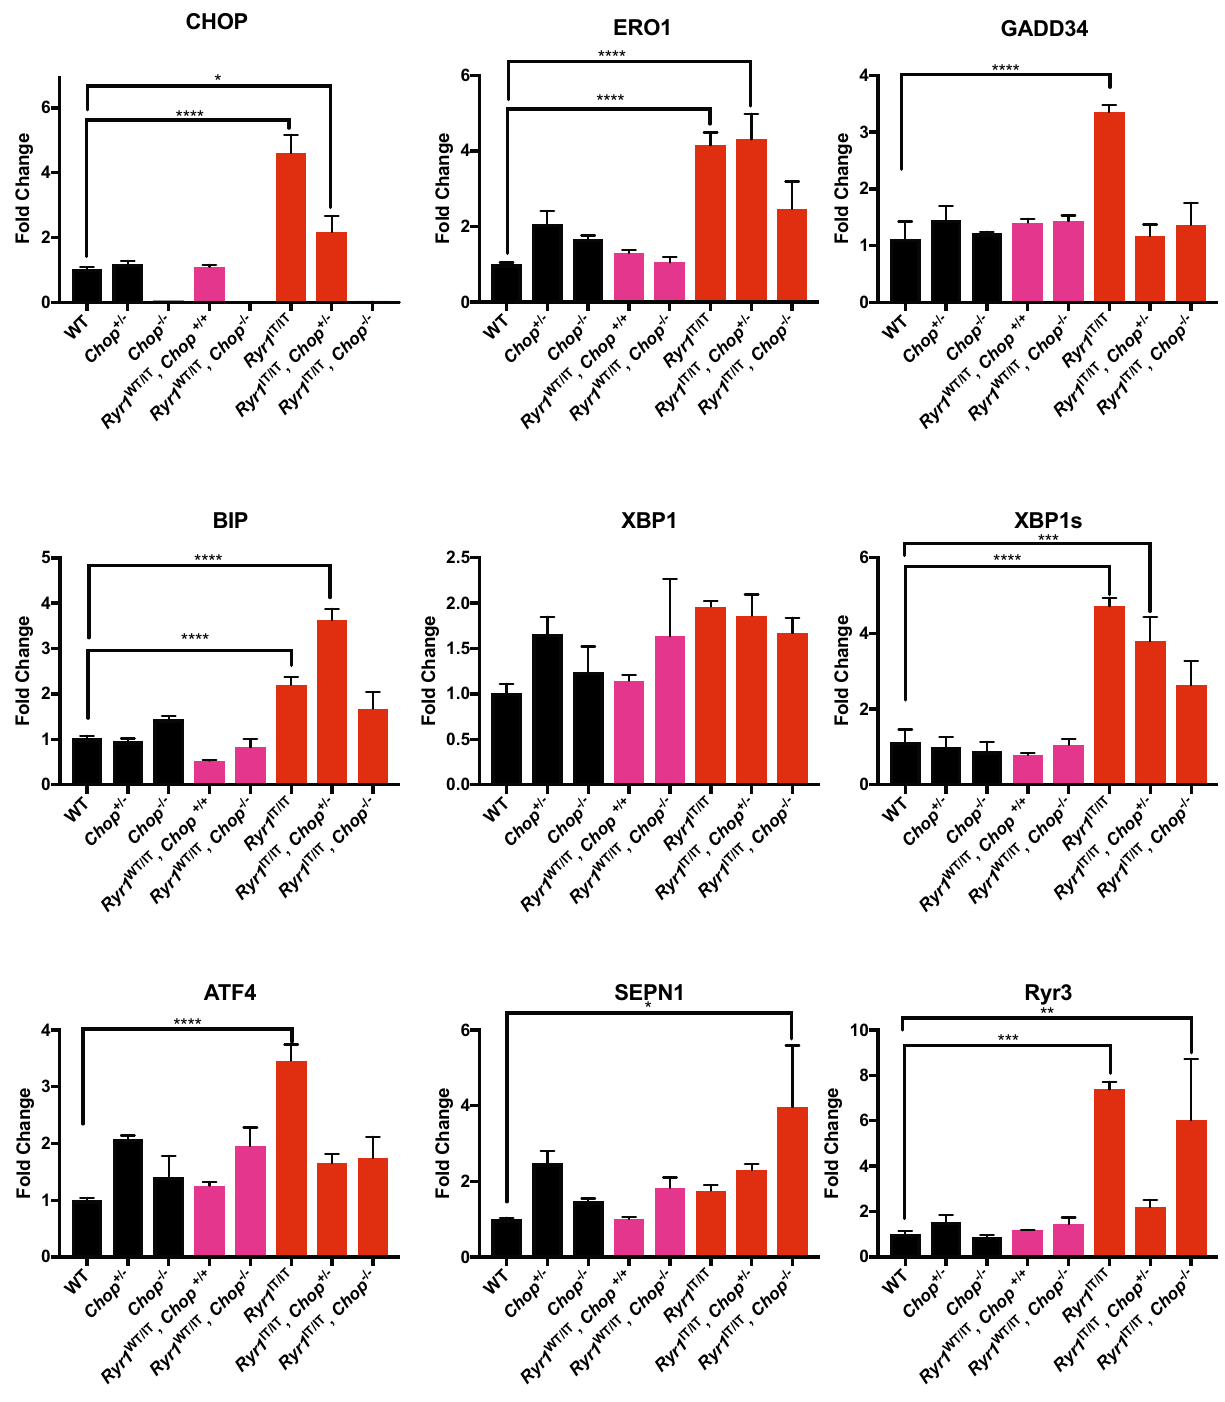
Figure 2. Analysis of ER stress and UPR in skeletal muscle with mixed Ryr1 I4895T CHOP background. Semi- quantitative real-time RT-PCR analysis of ER stress/ER stress response markers (together with Sepn1 and Ryr3 ) from mRNA from leg muscles of newborn pups of the genotypes indicated ( N =